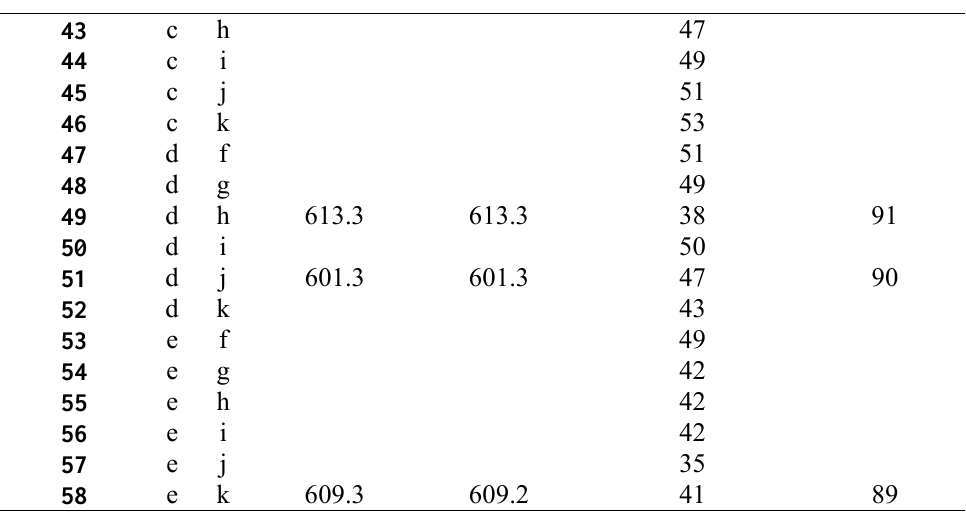
Table 2. Characterization of members from library B (E